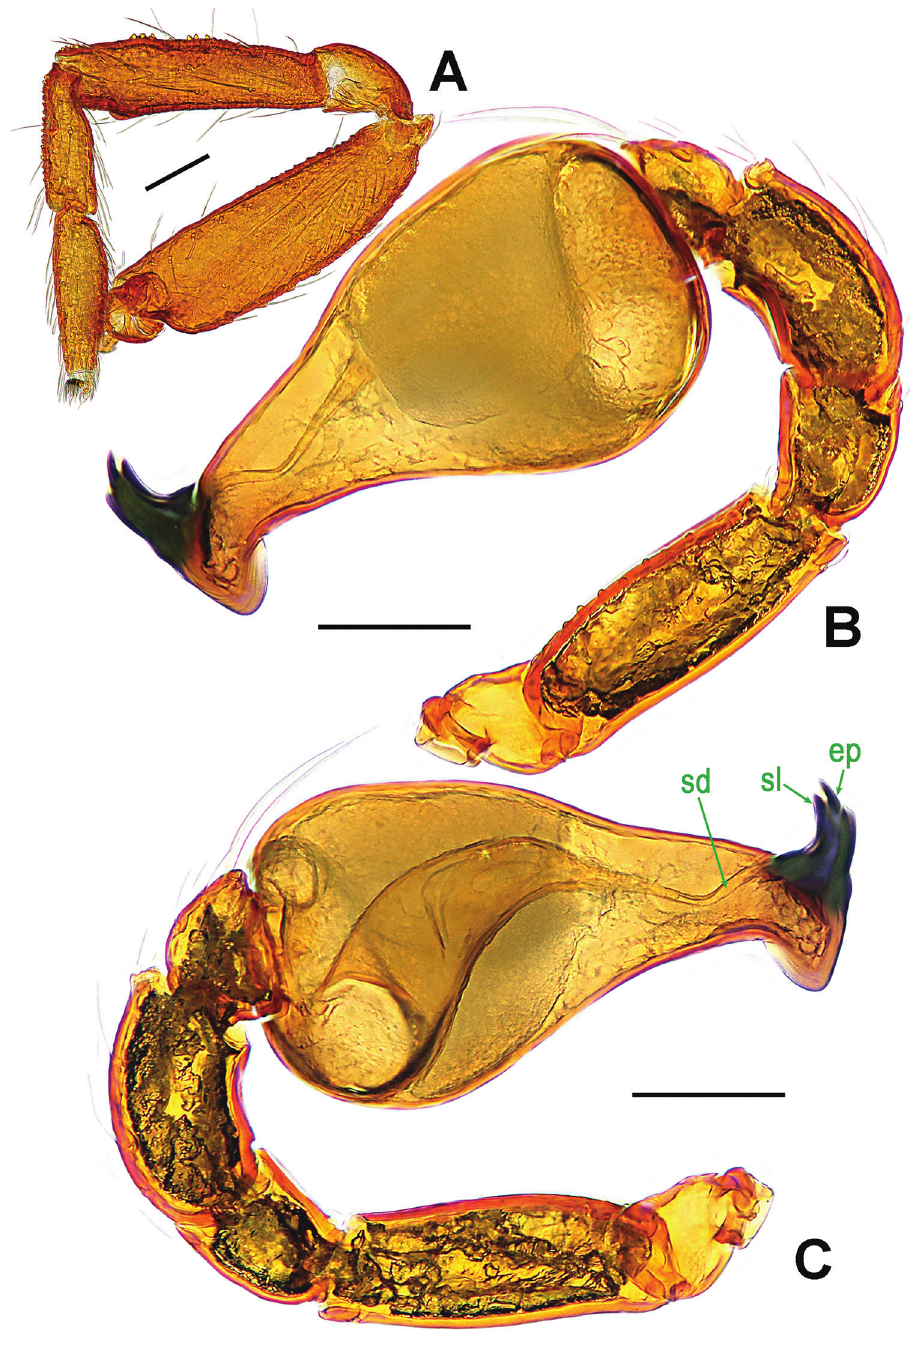
Figure 8. Ablemma malacca sp. n., male holotype. A left leg I, retrolateral B left palp, retrolateral C ditto , prolateral. Abbreviations: ep = embolic part of apes of palpal organ; sd = spermatic duct; sl = subterminal lamella. Scale bars: 0.10